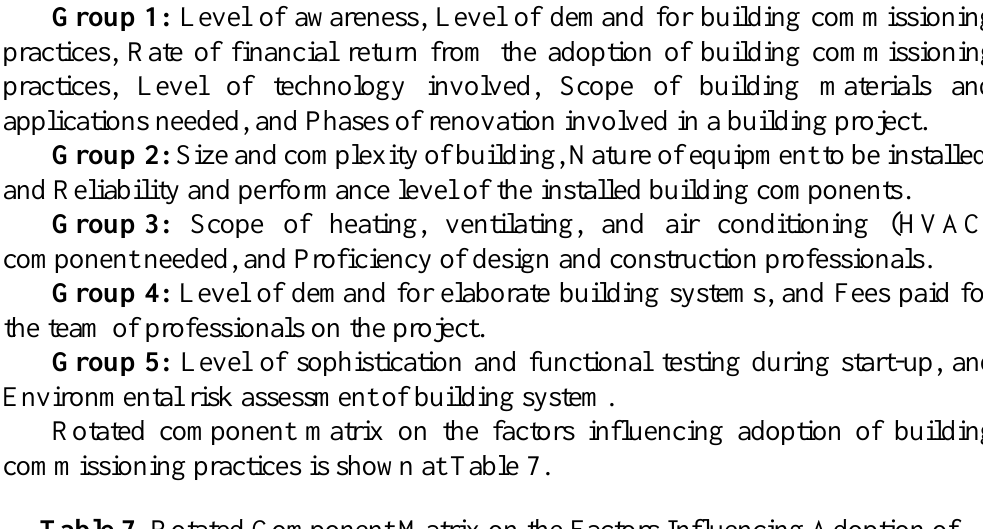
Table 7. Rotated Component Matrix on the Factors Influencing Adoption of Building Commissioning Practices (developed by the